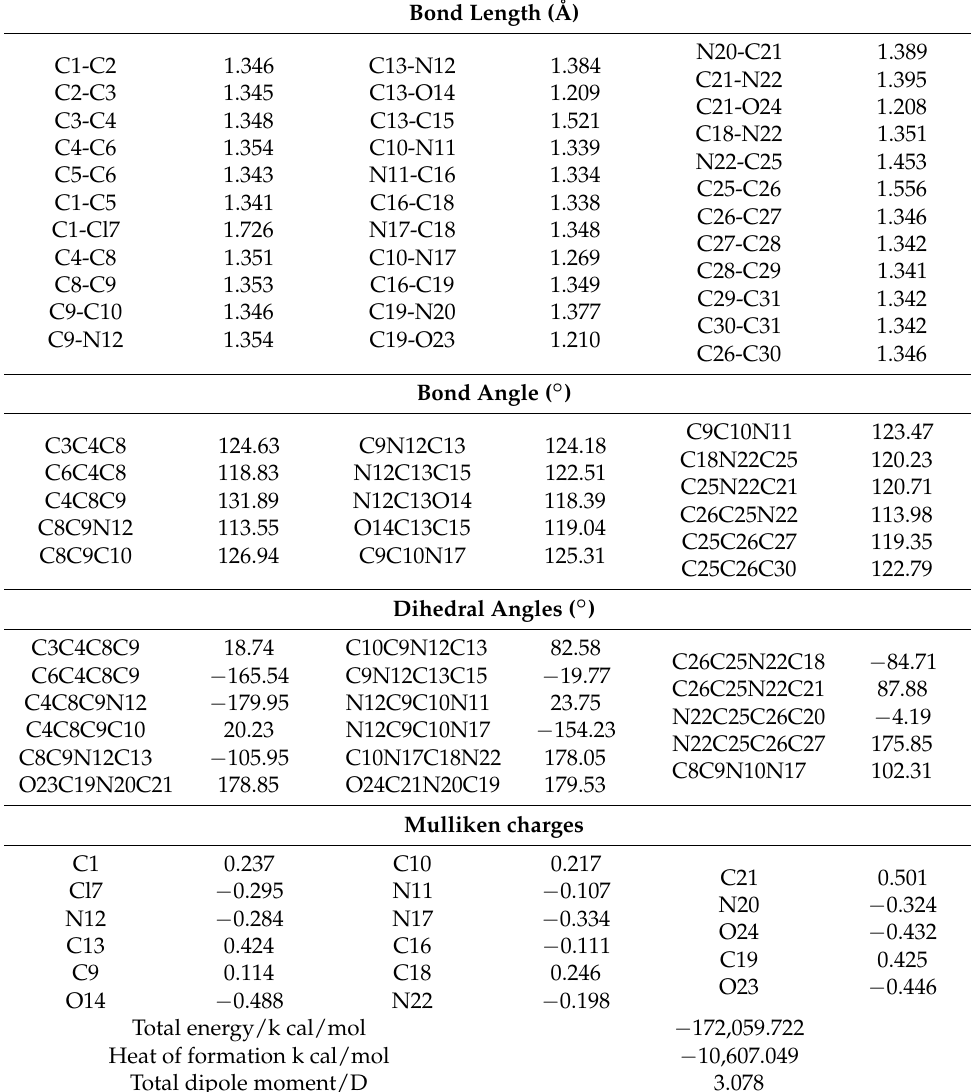
Table 5. Equilibrium geometric parameters bond lengths (Å), bond angles (°), dihedral angles (°), total energy (k cal/mol), heat of formation (k cal/mol), Mulliken charges over atoms and dipole moment of the N-(1-(3-benzyl-2,6-dioxo-2,3,6,7-tetrahydro-1 H -purin-8-yl)-2-(4-chlorophenyl) vinyl)acetamide, compound 3 by using DFT